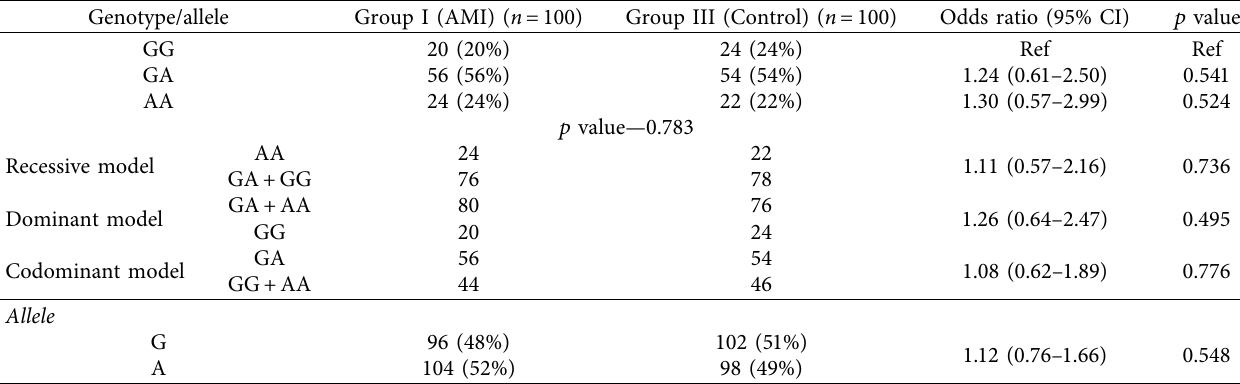
Table 6: Distribution of genotype and allelic frequency and association analysis of -844G/A polymorphism with AMI under different genetic